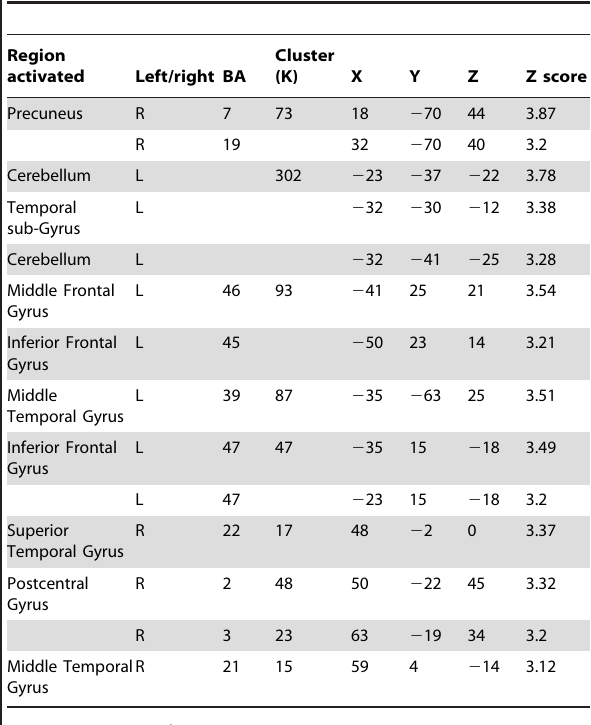
Table 4. Areas of significant activation in own . unknown infant contrast* controlling for breastfeeding.*